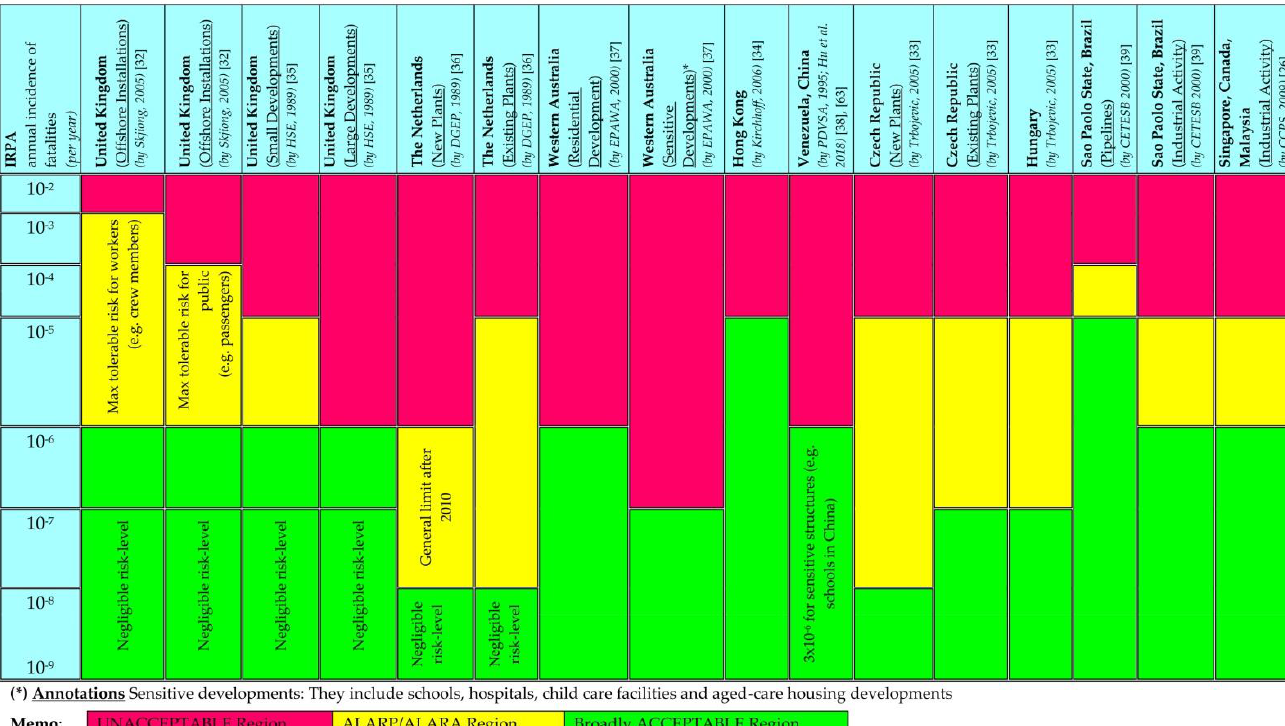
Figure 14. Comparison of the individual RACs adopted all over the world.